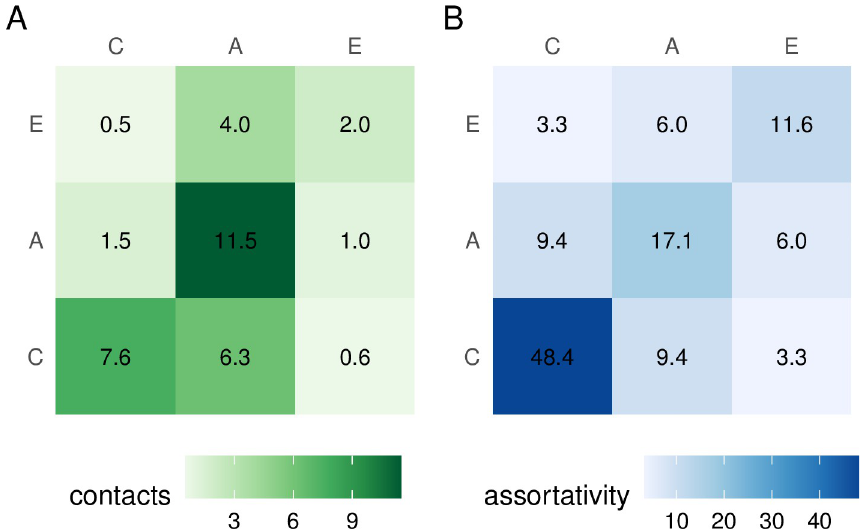
Fig 1. Base contact and assortativity matrices. A: contact matrix derived from the POLYMOD study, based on surveys conducted in 2005–2006, used without further transformation in the M0 model and with reciprocity correction in the M1 model. B: assortativity matrix derived from POLYMOD matrix, by decoupling the POLYMOD demographic structure from base contact matrix. Numbers within cells represent contact rates between the column- row age-group pairs. A = adults; C = children; E = elderly.